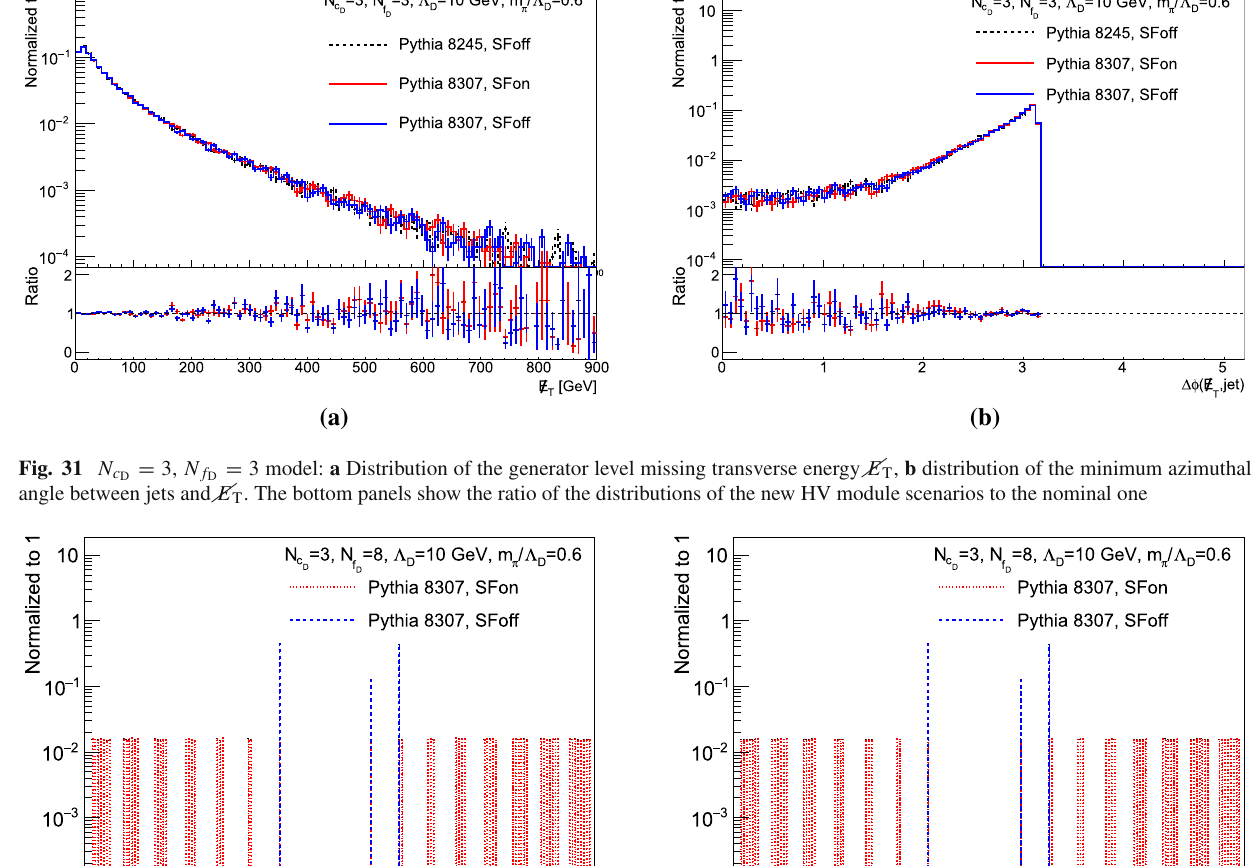
= 3, N = 3 model: a distribution of the number of ρ Fig. 30 N c f D D the distributions of the new HV module scenarios to the nominal one